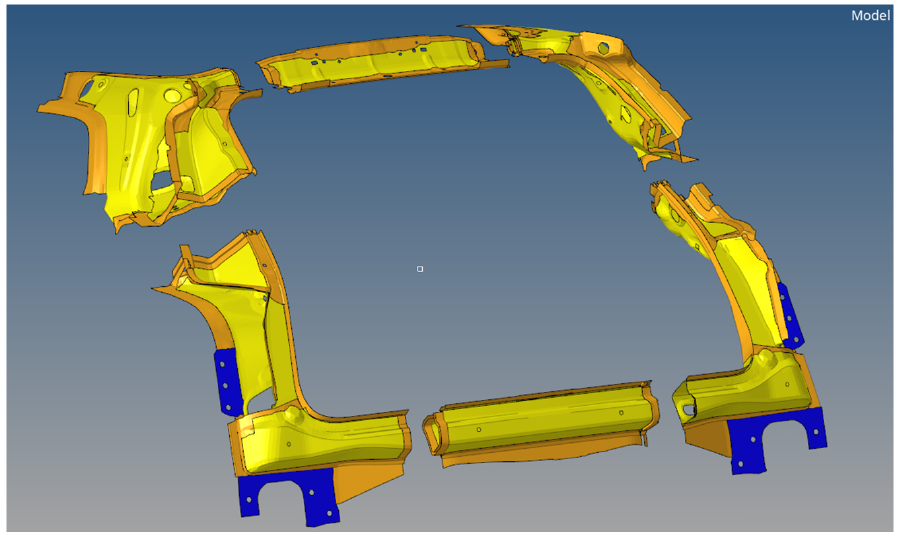
Figure 10. Aluminum rear part, to be internally optimized and then 3D printed, with highlight of the subdivision in 6 parts.